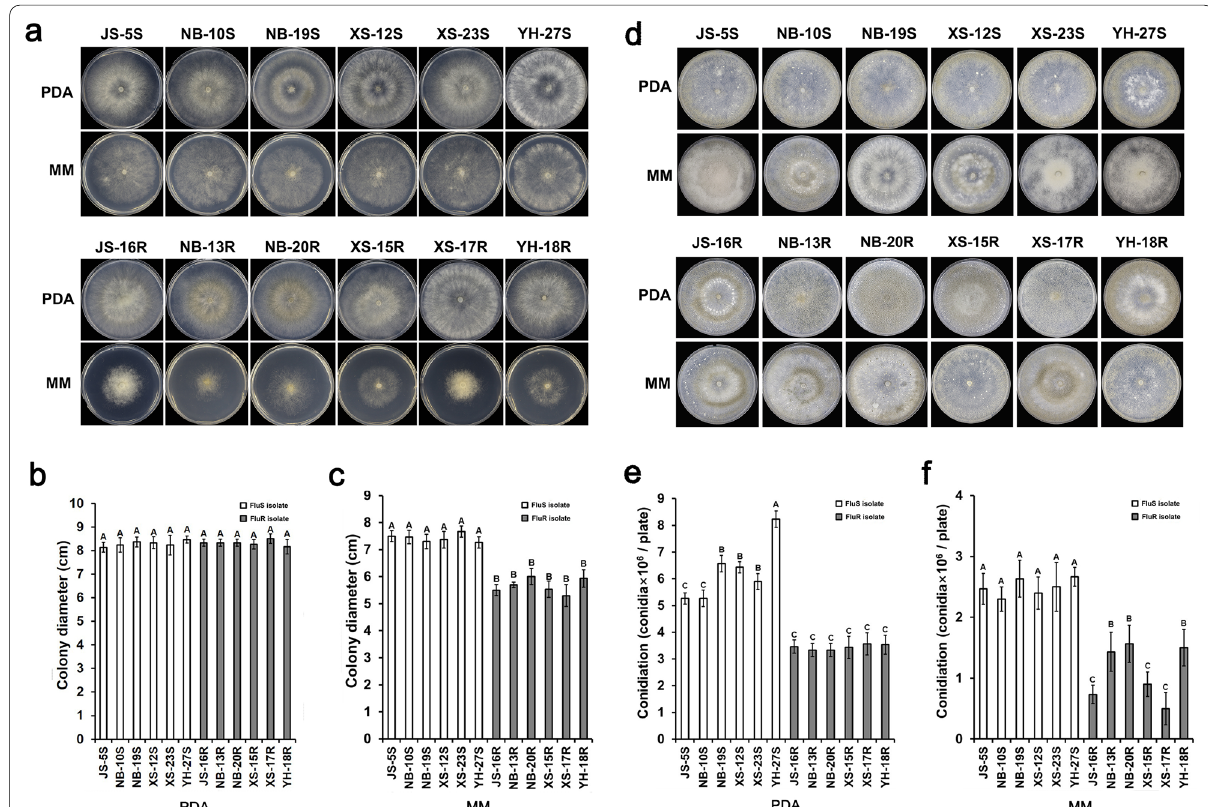
Fig. 1 Mycelial growth rate and conidiation capacity of FluS and FluR isolates of B. cinerea . a Colony morphology of FluS and FluR isolates grown on PDA and MM medium at 25 °C for 3 days. Column diagram showing colony diameter of FluS and FluR isolates grown for 3 days on PDA ( b ) and MM ( c ). d Conidiation of FluS and FluR isolates grown on PDA and MM at 16-h photoperiod for 14 days. Column diagram showing conidiation capacity of FluS and FluR isolates grown on PDA ( e ) and MM ( f ). For statistical analysis, bars denote standard errors of three repeated experiments. Values on bars followed by the same letter are not significantly different from each other at P =